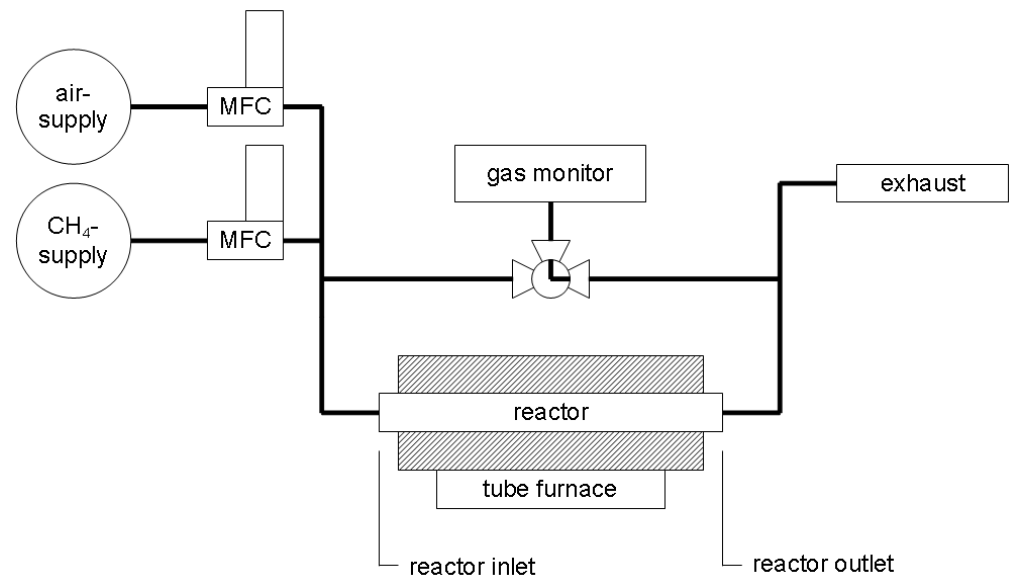
Figure 15. Schematic illustration of the catalyst testing